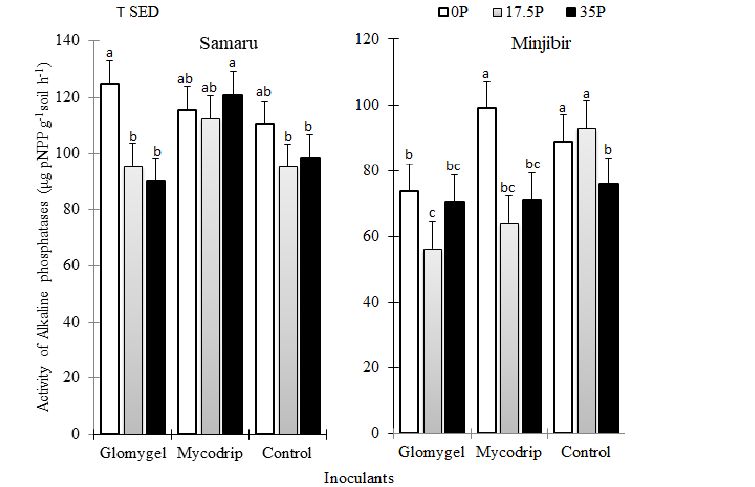
Figure 1. Effect of P fertilizers and inoculation with mycorrhizae on alkaline phosphatase activities